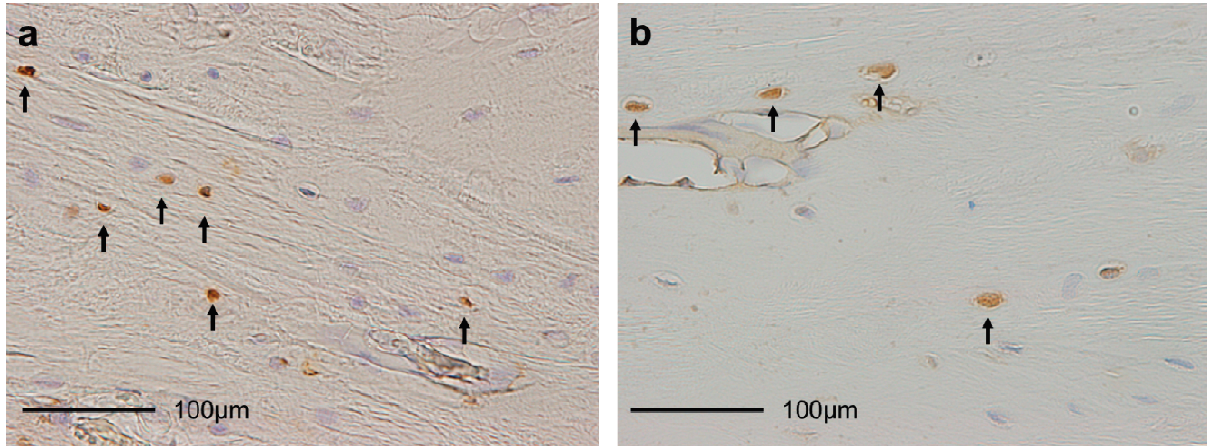
Figure 1. Histological sections of the patella-tendon (PT) insertions (×400). ( a ) TUNEL staining. Brown cells (arrows) are TUNEL-positive chondrocytes; and ( b ) Proportion of proliferating cell nuclear antigen (PCNA) staining. Brown cells (arrows) are PCNA-positive